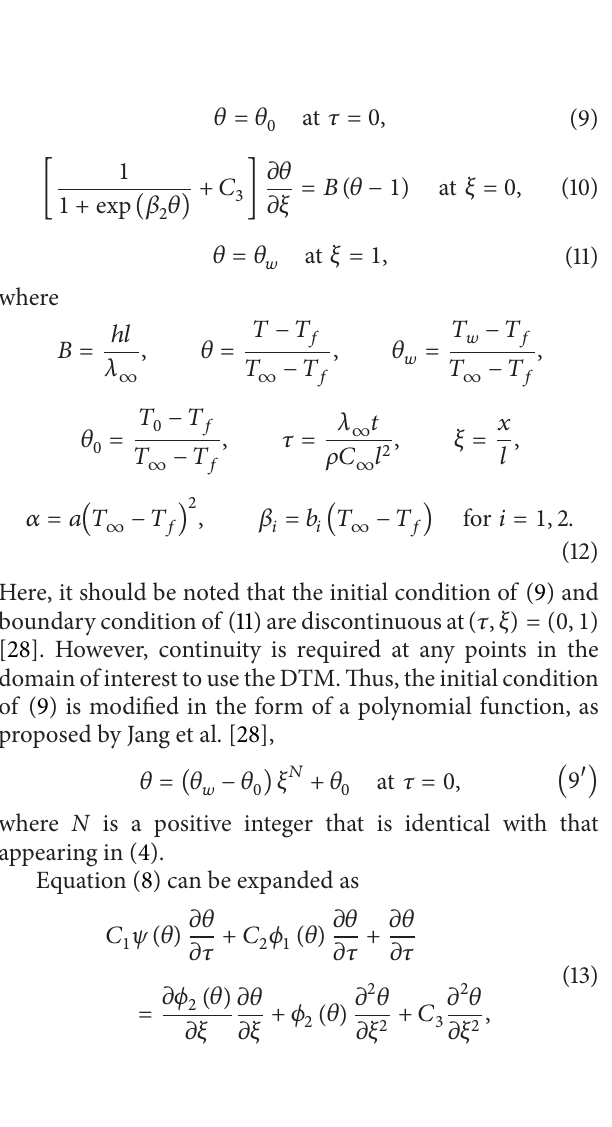
Figure 2: Temperature dependencies of (a) apparent specific heat and (b) thermal